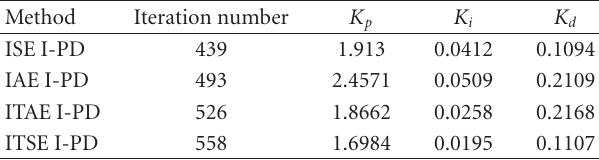
Table 7: Optimised parameters for CSTR